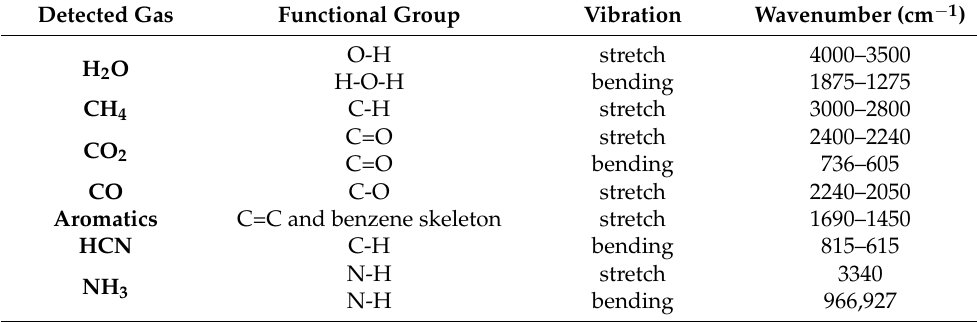
Figure 9. Two-dimensional infrared spectra of volatile products at different temperatures during pyrolysis of coal samples (( a ): infrared spectra of volatile products of SGT-1, ( b ): infrared spectra of volatile products of SGT-4). Table 2. Gas species and functional groups characterized by the wavenumber range